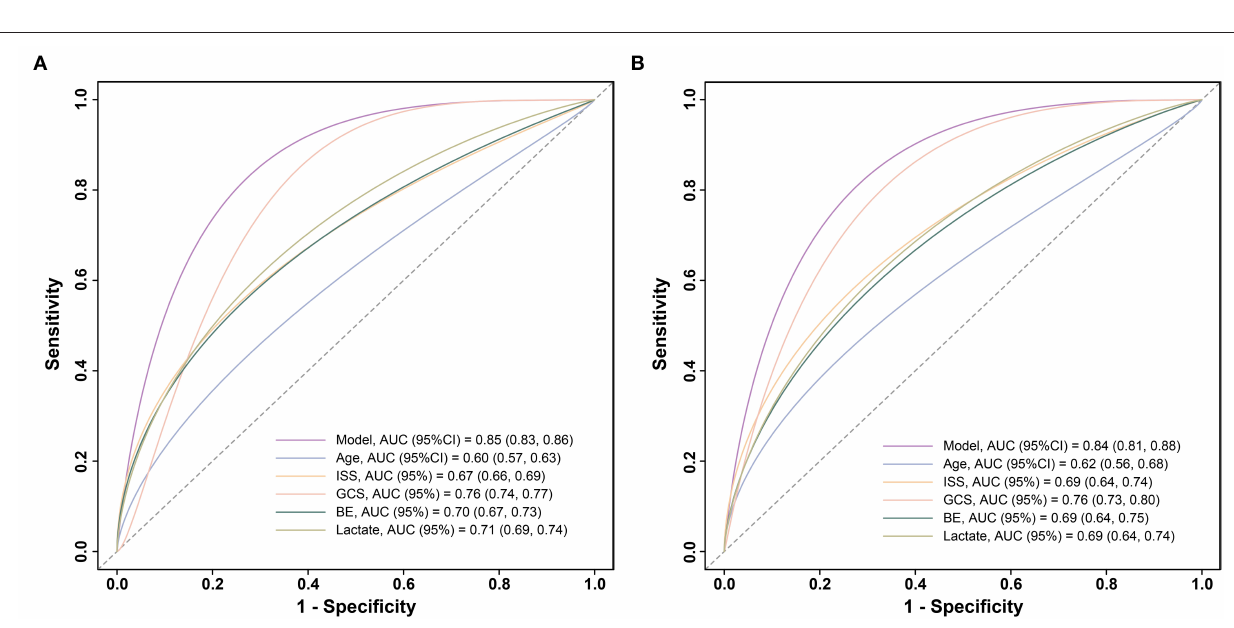
Furthermore, we utilized DCAs to evaluate the net benefit of the model for decision-making. As illustrated in Figure 5 , in the training cohort, the model is applicable when the threshold is between 0.01 and 0.9, as net benefits are > 0, while the validation cohort has a valid range of between 0.01 and